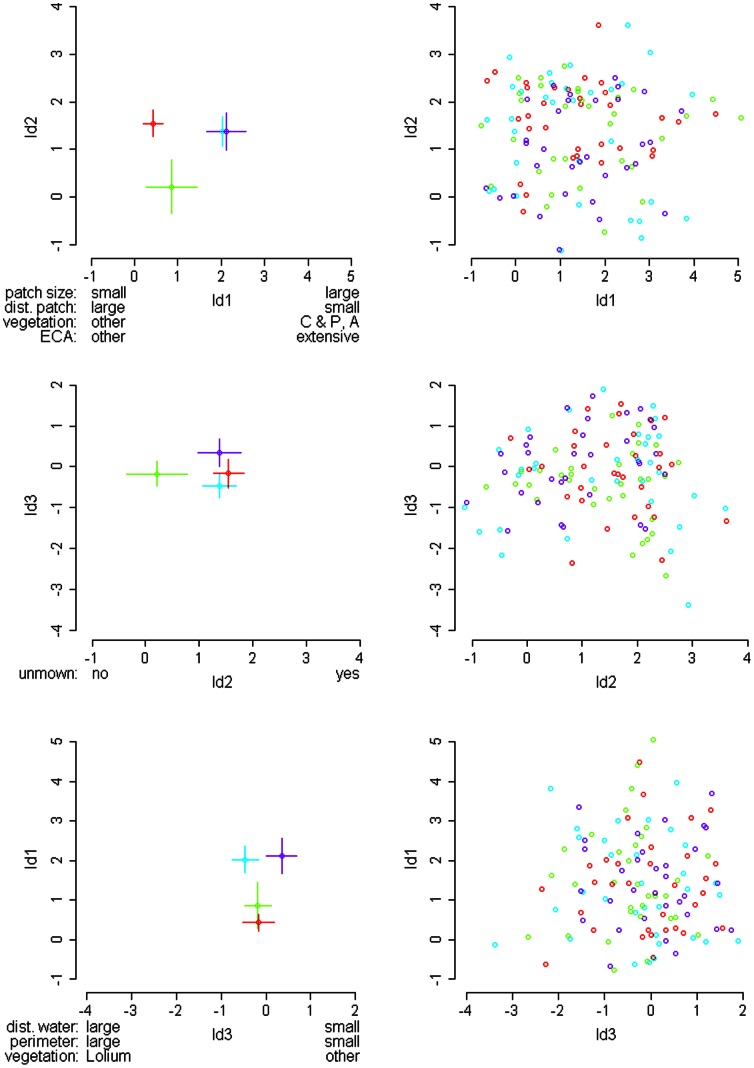
Differentiation of patch types based on three linear discriminant functions.Plots on the left show group means ±95% CI, plots on the right the discriminant function scores. For each linear discriminant function ( =  ld), the most influential variables according to Table 6 are indicated along with their specifications. Symbols: o  =  unoccupied patches, o  =  colonized patches, o  =  extinct patches, o  =  patches occupied in both years. Abbreviations: “dist. patch”  =  distance to nearest patch, “vegetation”  =  vegetation type (with C  =  Carex, P  =  Poa, A  =  Arrhenatherum), “ECA”  =  ECA type (extensive meadow), “unmown”  =  unmown vegetation, “dist. water”  =  distance to water, “perimeter”  =  perimeter index.